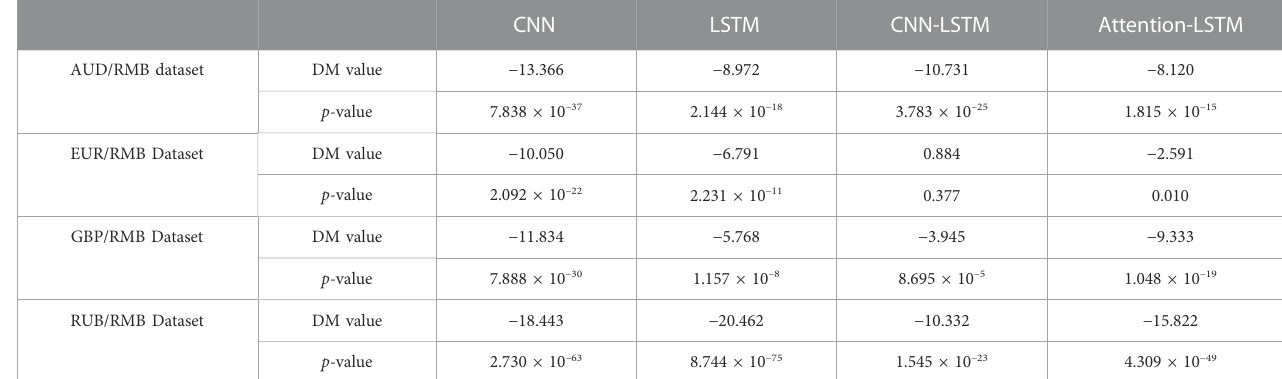
TABLE 2 DM detection of the proposed model and other